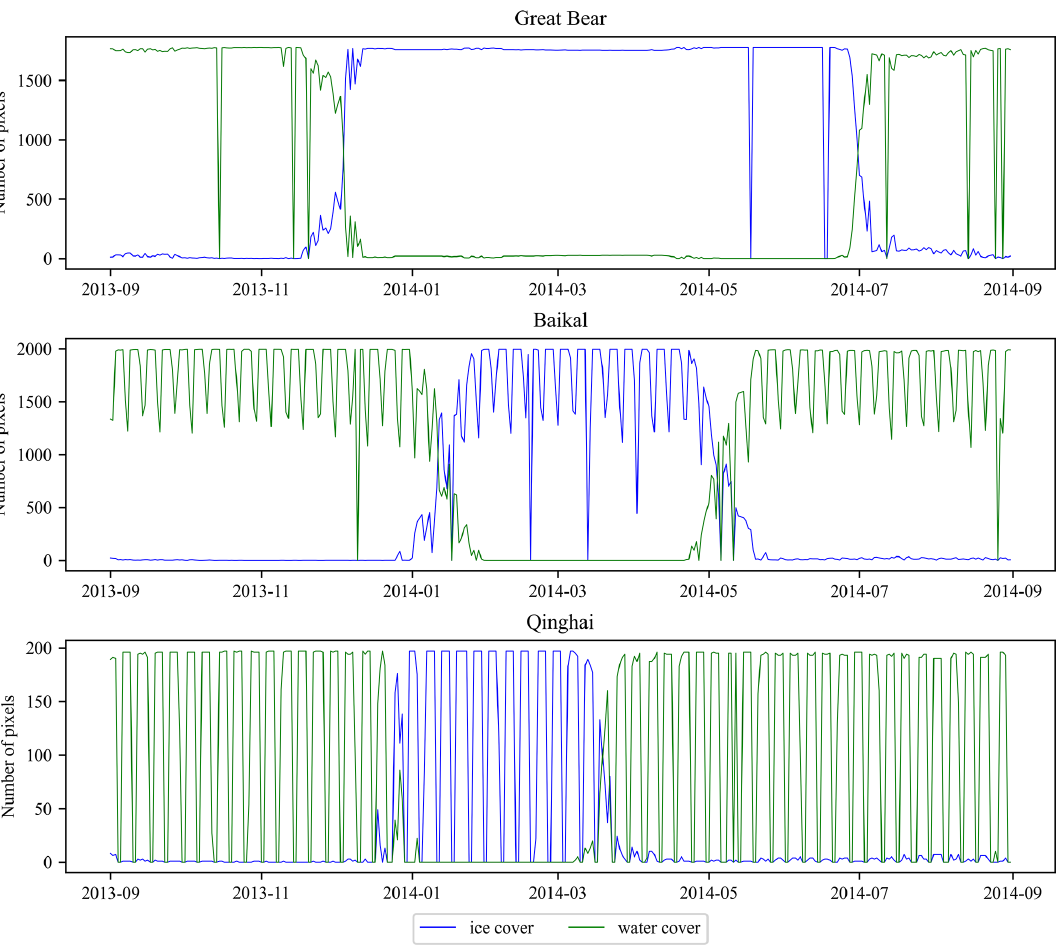
Figure 5. Variations in the number of lake ice and open water pixels for (a) Great Bear, (b) Baikal, and (c) Qinghai in 2014. The periodic fluctuations in the curves are due to the existence of orbital